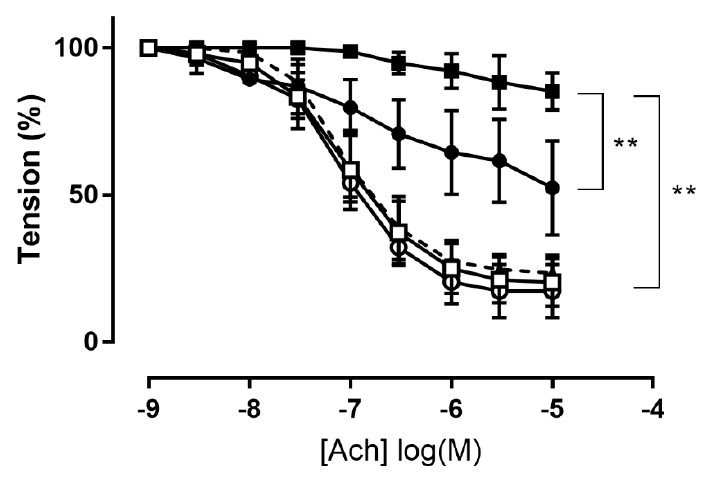
Figure 3. Effect of 6 (100 µ M) on acetylcholine-induced vasodilation in endothelium-intact rat aortic rings. Control: rings incubated with vehicle only (DMSO) (straight line, (cid:3) ); rings incubated with 6 (straight line, ); rings incubated with 500 µ M pyrogallol (straight line, (cid:4) ); rings incubated with 6 and (cid:35) 500 µ M pyrogallol (straight line, • ); rings incubated with catechin (10 mM) and 500 µ M pyrogallol (dotted line, ∆ ). Statistical analyses were made using Student’s t -test for unpaired data. ** p < 0.01 vs. the pyrogallol